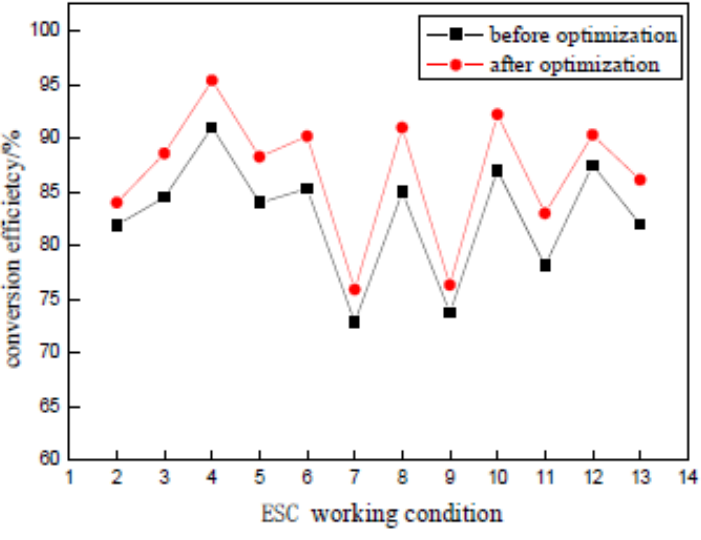
Fig. 16 Comparison of NOx conversion